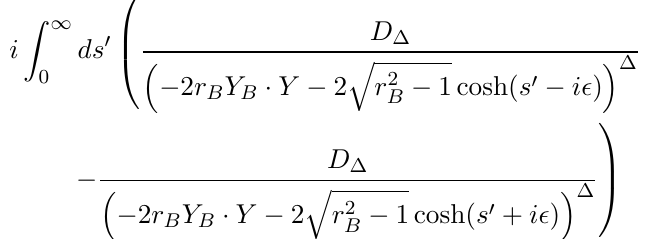
Figure 8 . The analytic structure in the complex s The blue line is the contour of